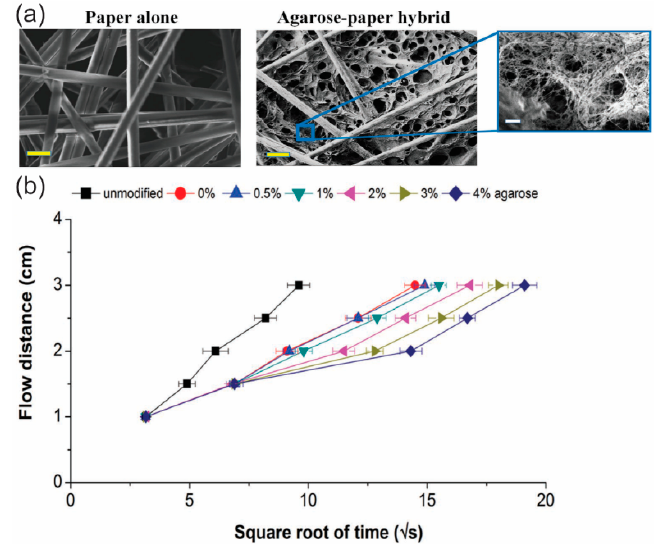
Figure 9. Regulation of the fluid flow in a p-CMF device by controlling the permeability of the paper channel. ( a ) SEM images of paper (left) and of agarose-paper (right). ( b ) Fluid flow distance versus square root of time in paper channels with and without treating with various concentrations of agarose. Reprinted with permission from the authors of [79]. Copyright 2016 WILEY-VCH Verlag GmbH & Co. KGaA, Weinheim.